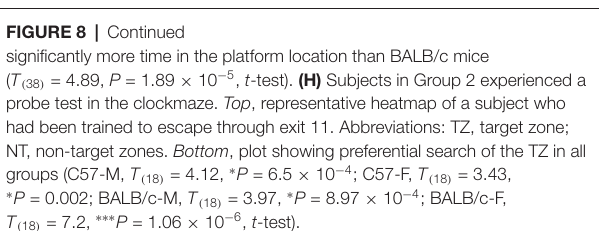
( Figure 9E ) with a handheld thermography camera